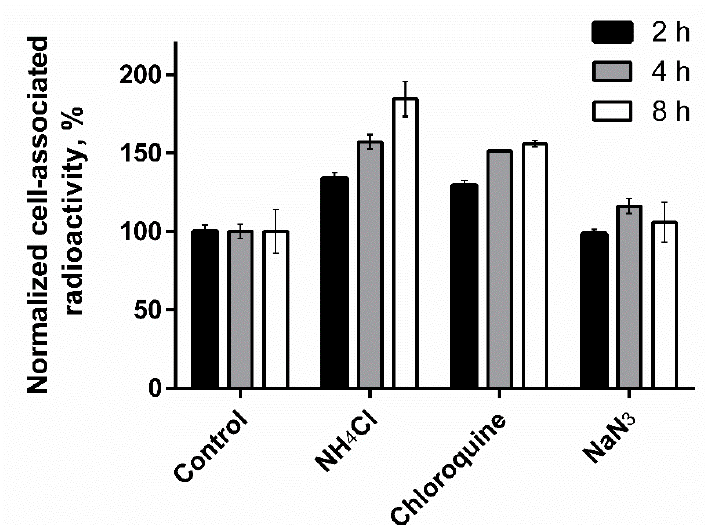
Figure 6. Normalized cell-associated radioactivity of [ 125 I]I-Tyr-PEG 2 -RM26 in the presence 20 mM sodium azide/10 mM 2-deoxyglucose, 100 µM Chloroquine, 20 mM ammonium chloride by PC-3 cells during continuous incubation at 37 °C. One set of culture dishes was tested as control.